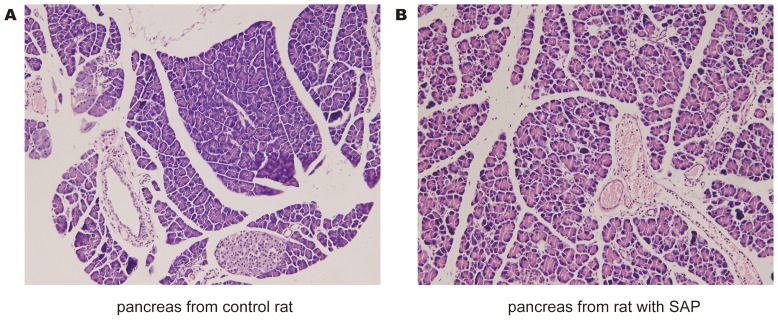
Confirming induction of the severe acute pancreatitis model.Assessment of pancreatic injury by HE staining. Pancreatitis was induced by pancreatic-ductal perfusion with 5% Sodium taurocholate. All rats were sacrificed at 24 h after disease model initiation. A: A typical photomicrographs of HE stained tissue obtained from control rat. B: A photomicrograph of pancreatic injury which includes pancreatic edema, neutrophil infiltration, necrosis and hemorrhage.